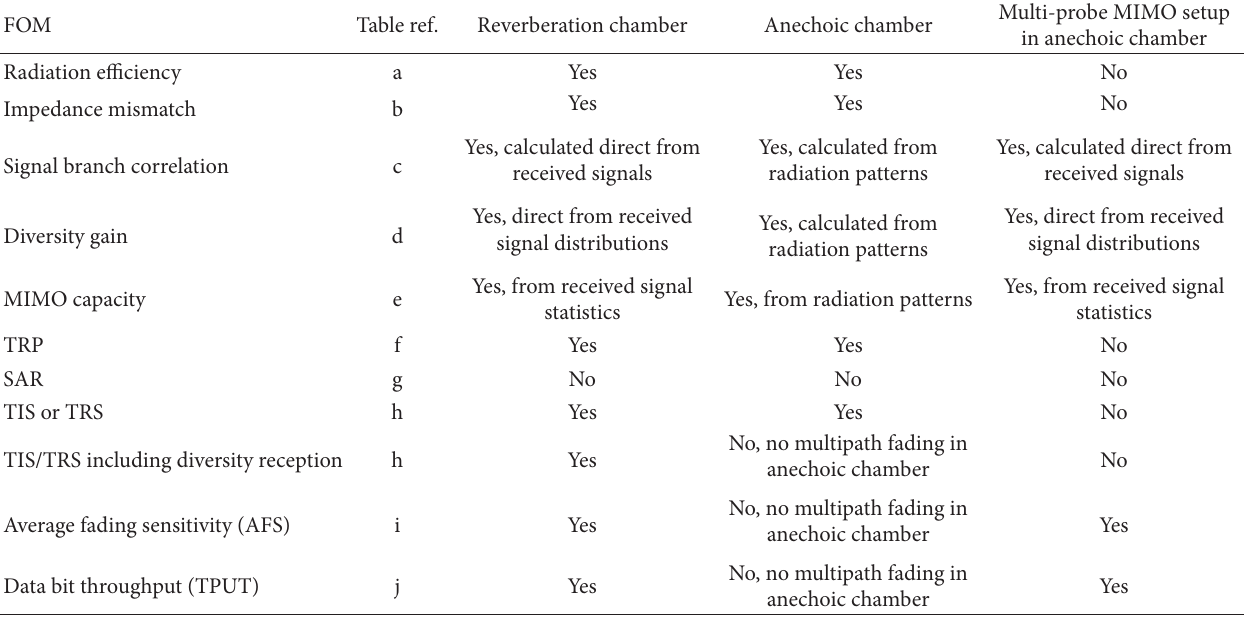
Multi-probe MIMO